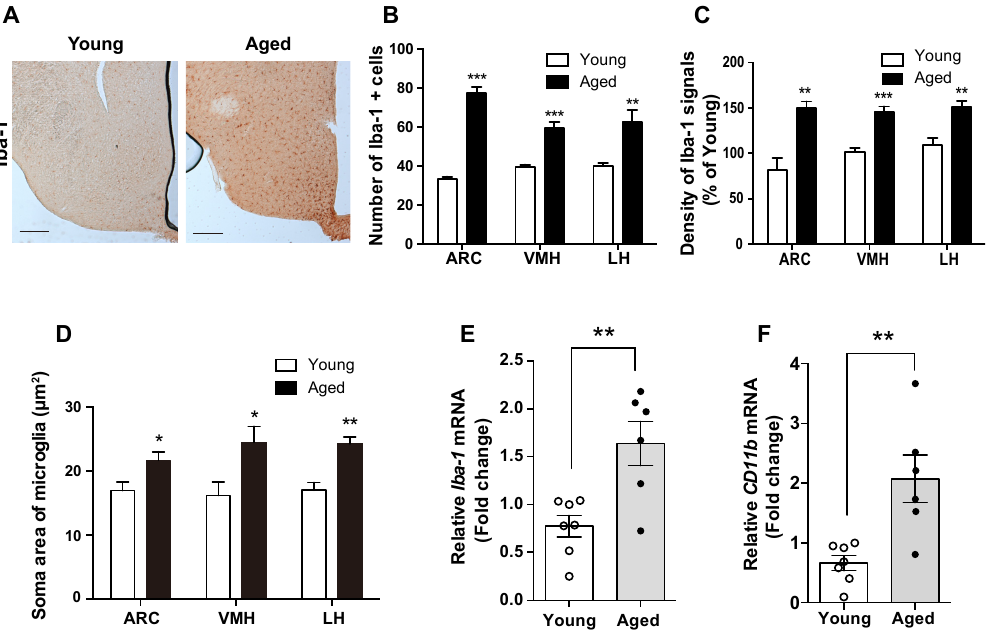
Figure 2. Aged mice display microglial activation and inflammation in the hypothalamus. Hypothalamic sections from young and aged C57BL/6 mice were subjected to IHC. ( A ) Representative images showing the immunosignals of Iba-1 in the hypothalamus of young and old mice. Increases in ( B ) the number of microglial cells, ( C ) the intensity of Iba-1 immunoreactive signals, and ( D ) the soma area of microglial cells were observed in the ARC, VMH, and LH of the aged mice compared with young mice. The mRNA levels of ( E ) Iba-1 and ( F ) CD11b were significantly increased in the hypothalamus of the aged mice compared with those in the young mice. The results are presented as the means ± SEMs. n = 6–7 for each group. * p < 0.05, ** p < 0.01, *** p < 0.001 for the aged group versus the young group. Scale bar = 100 μ m.